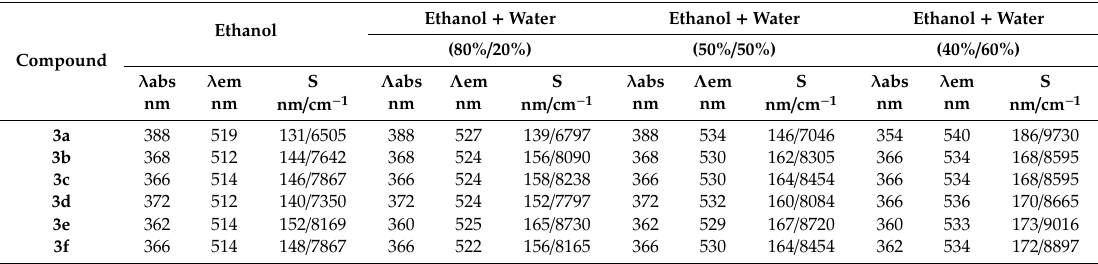
Table 3. Spectroscopic properties of 3a – f depending on the amount of water in a solution. S—BioTek Stokes